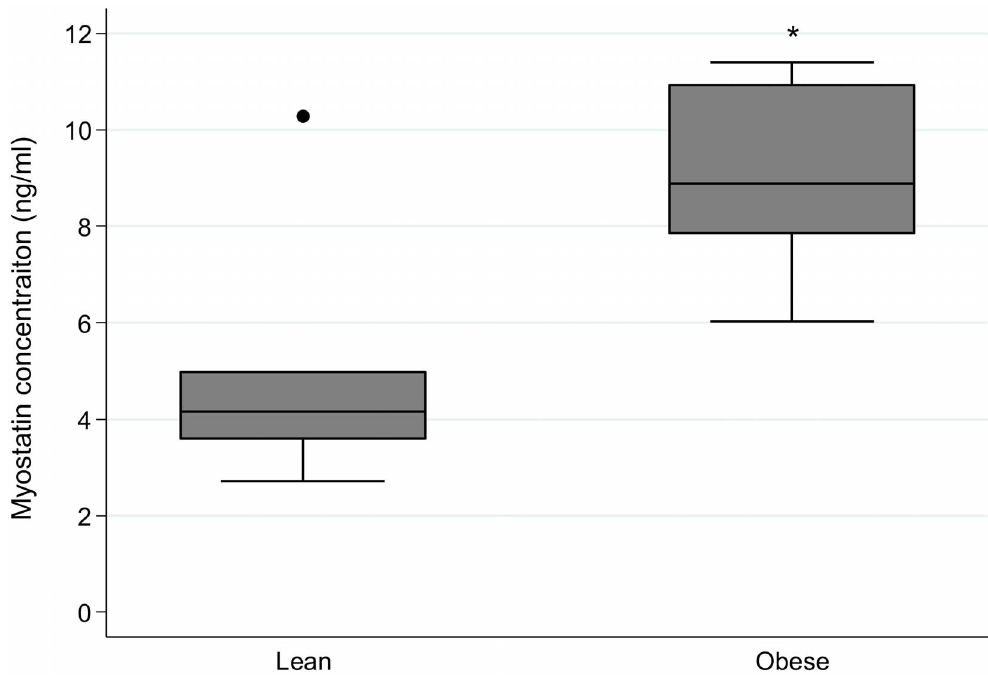
Figure 6. Circulating concentrations of myostatin protein in lean and obese horses and ponies. Circulating concentrations of mature myostatin protein were measured in blood serum using a commercially available ELISA kit. *denotes where values differ significantly (p , 0.05) from lean group. n=6/group.